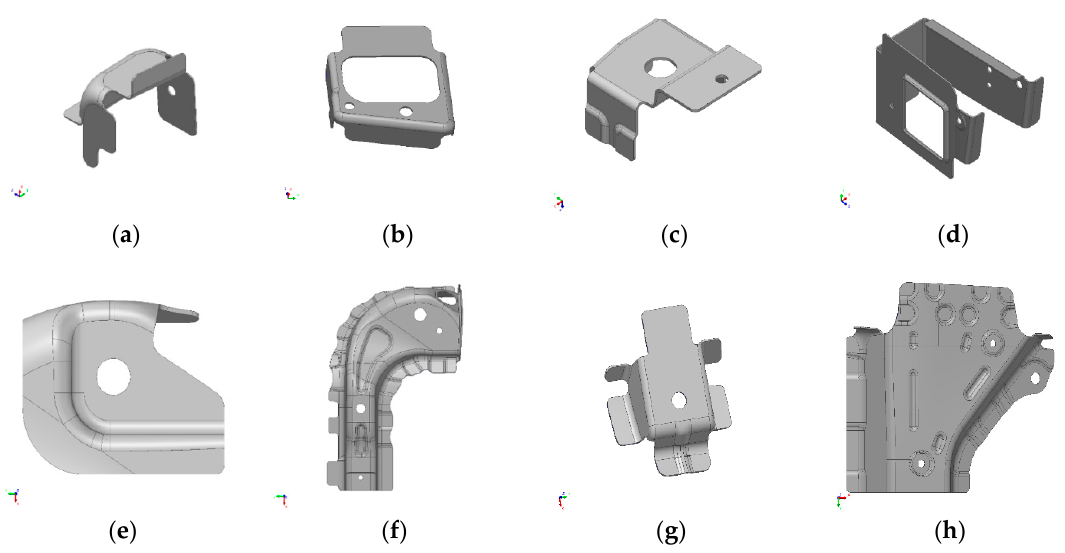
Figure 2. The computer aided design (CAD) model. ( a )–( h ) are a series of CAD model of vehicle body parts, respectively.